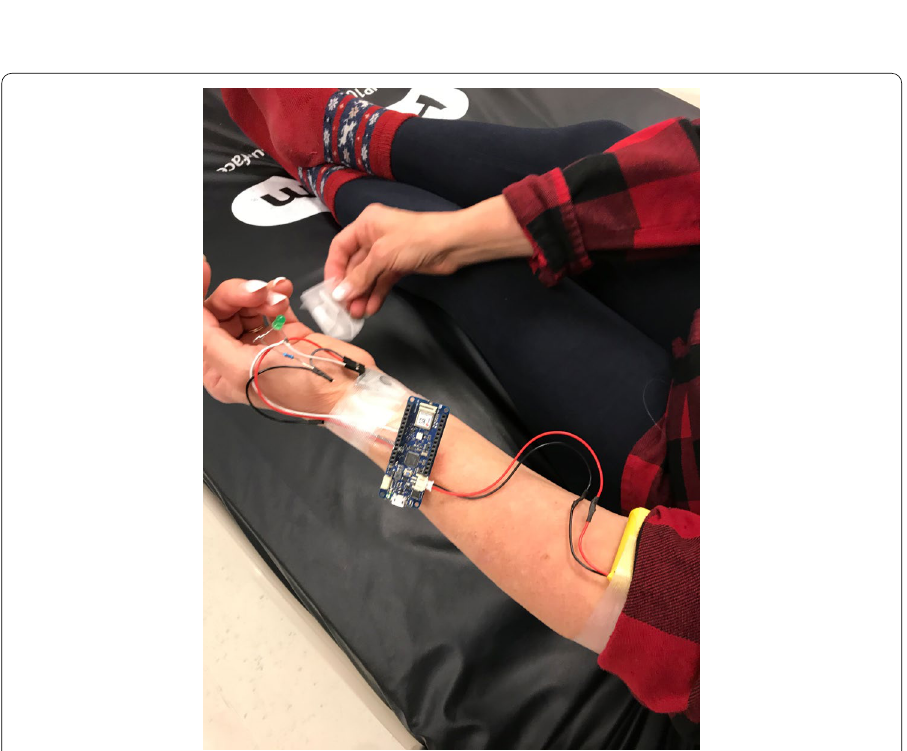
Fig. 3 Vibration motor, Arduino and battery pack ‘attached’ to the standardized